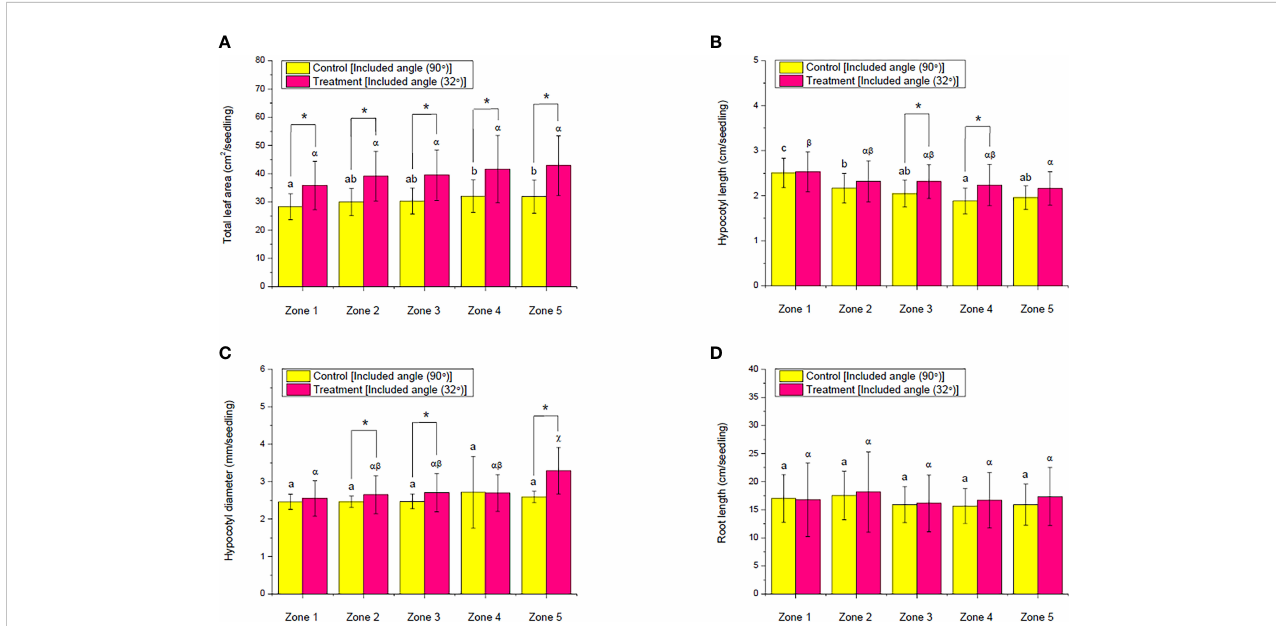
FIGURE 10 Comparison of the (A) total leaf area, (B) hypocotyl length, (C) hypocotyl diameter, and (D) root length of choy sum at seedling stage on day 16 grown in an indoor farm rack with and without the application of an adjustable lampshade-type re fl ector (ALR). The asterisks (*) indicate signi fi cant differences found between the control and treatment (Student ’ s t -test; p < 0.05), while different Greek alphabets ( a , b , and c ) and the lowercase letters (a, b, and c) indicate signi fi cant differences among all the zones with and without the application of ALR ( N zone1 = 45, N zone2 = 38, N zone3 = 32, N zone4 = 26, N zone5 = 19, one-way ANOVA; Tukey multiple-comparison; p <